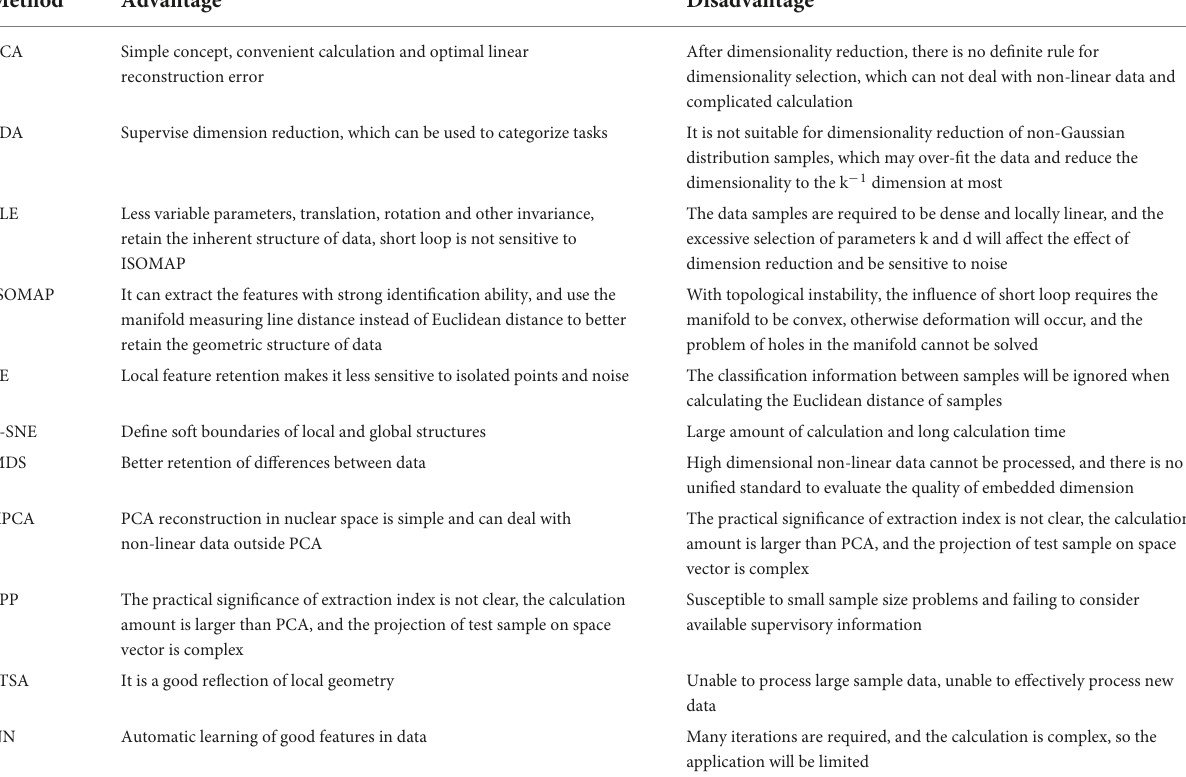
TABLE 1 Advantages and disadvantages of various dimensionality reduction